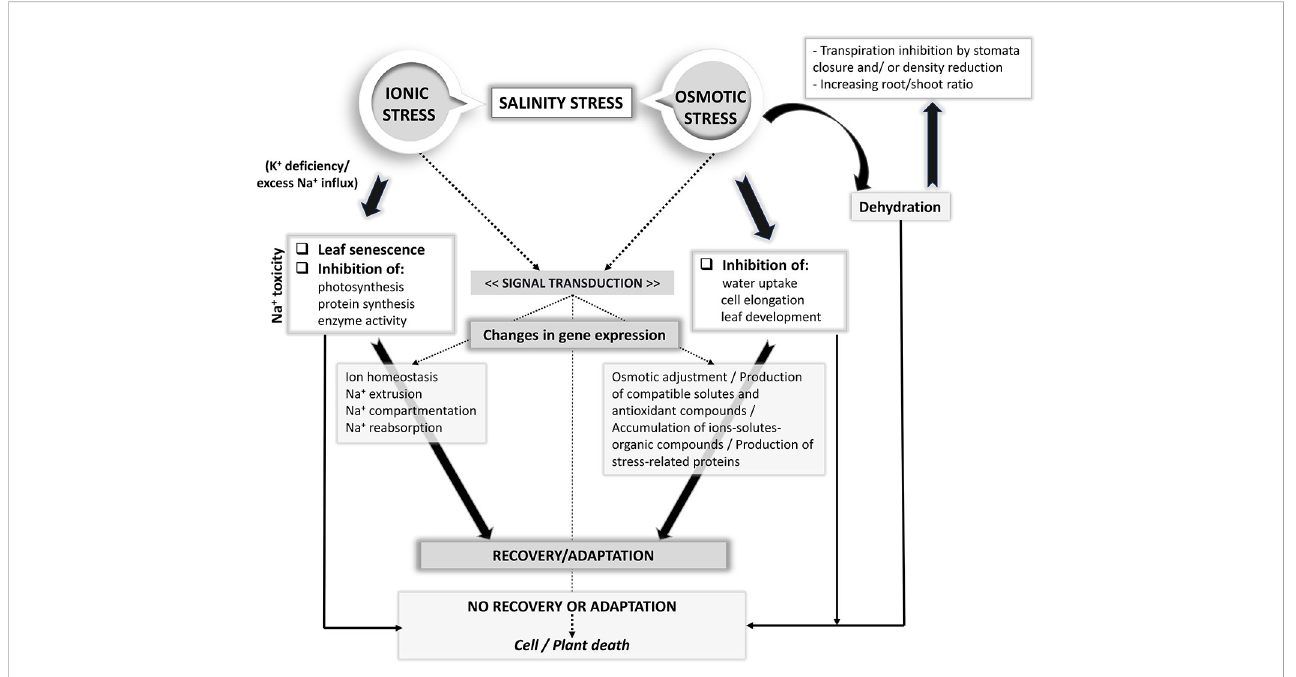
FIGURE 1 Plant adaptive responses to salt